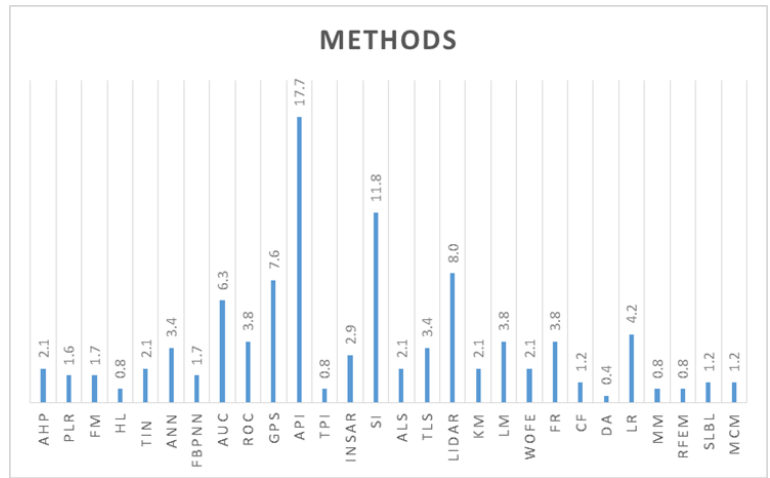
Figure 2. Diagram illustrating the most and least frequently used methods.